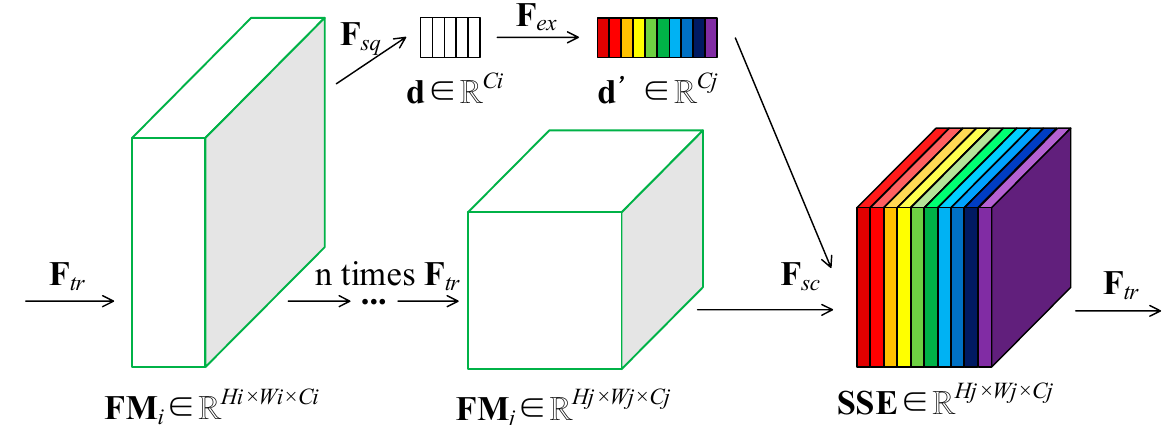
Figure 2. Structure of SSE module. F tr refers to any matrix transformation in the network, F sq refers to the Squeeze operator in the SSE module, F ex refers to the Excitation operator, F sc refers to channel-wise multiplication.